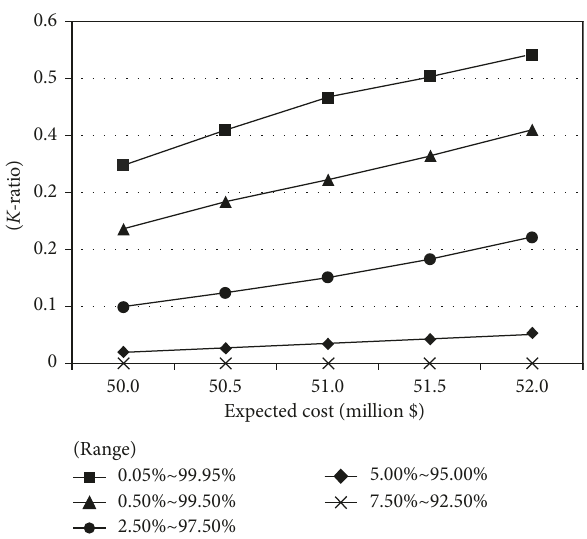
Figure 7: K -ratio at GMP of $53